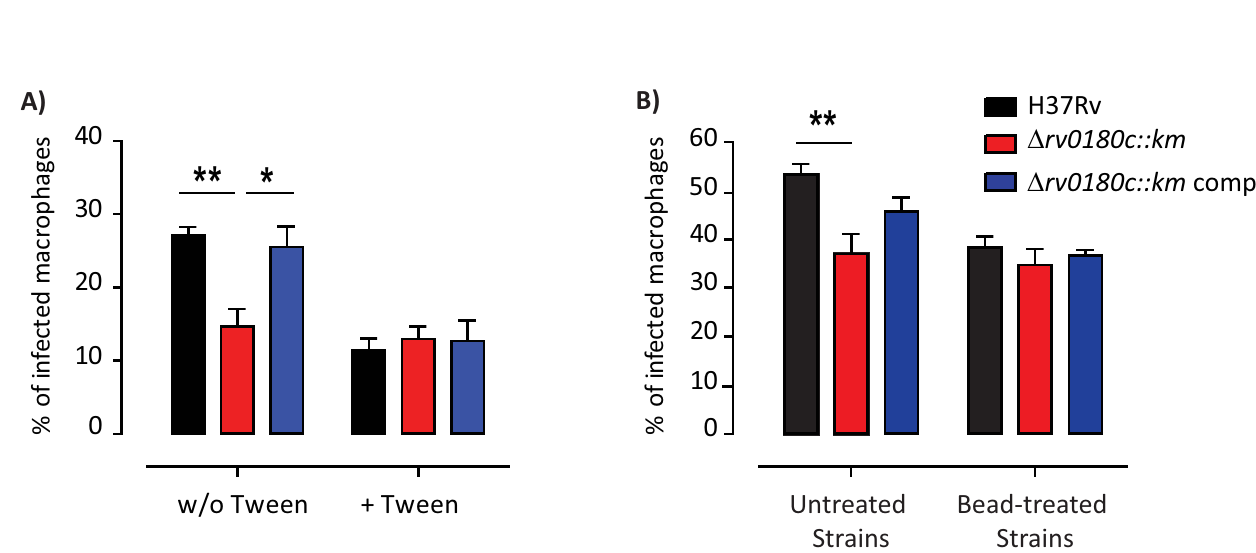
Fig 6. Removal of the bacterial capsule suppresses the differential uptake of the Δ rv0180c :: km mutant. The parental H37Rv, the Δ rv0180c :: km mutant, or the Δ rv0180c :: km complemented strains were grown (A) in 7H9 ADC liquid medium with or without Tween-80 0.05% or (B) in Sauton liquid medium before removal of the capsule using agitation with glass beads. Untreated bacteria were used as control. (A,B) hMDMs were then incubated with bacterial preparations at MOI 10:1 for 60 min at 37˚C, fixed and processed for analysis by confocal fluorescence microscopy. Vertical bar plots represented the percentage of infected cells. The values are means +/- SEM calculated from 3 donors. The significance of difference between strains was evaluated using the one-way ANOVA followed by Bonferroni’s post hoc test; � p < 0,05, �� p <